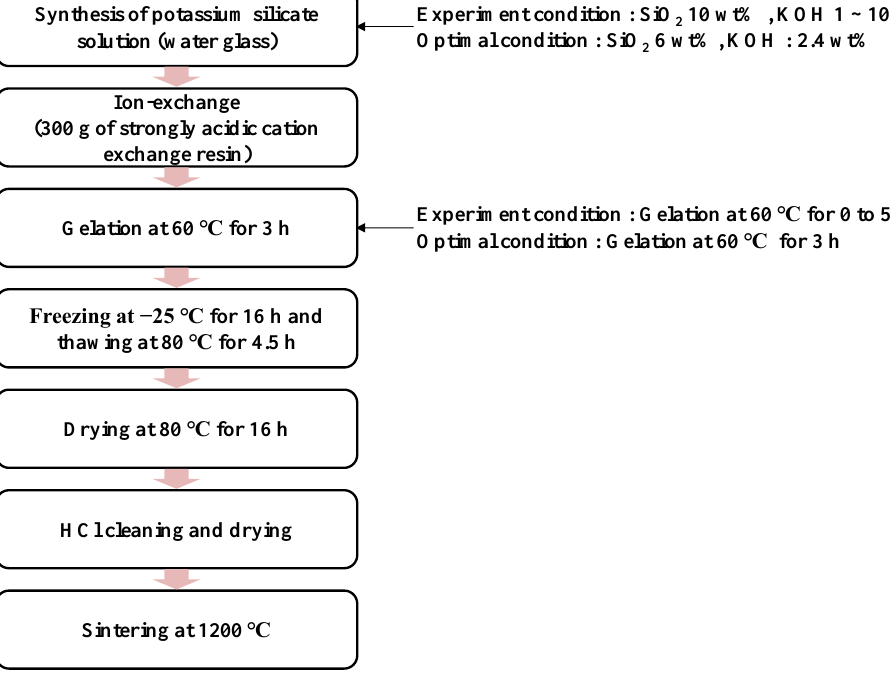
Figure 1. Synthesis process flow of the fumed silica-based ultra-high-purity quartz powder.